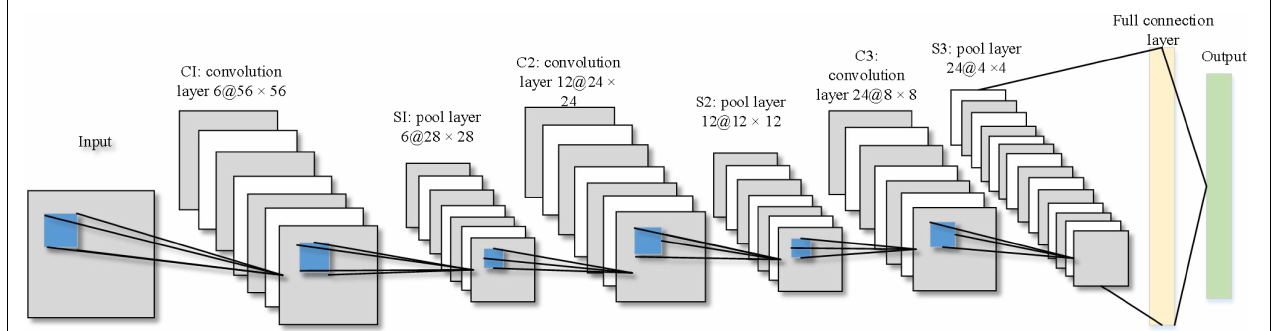
FIGURE 1 | Structure of seven-layer